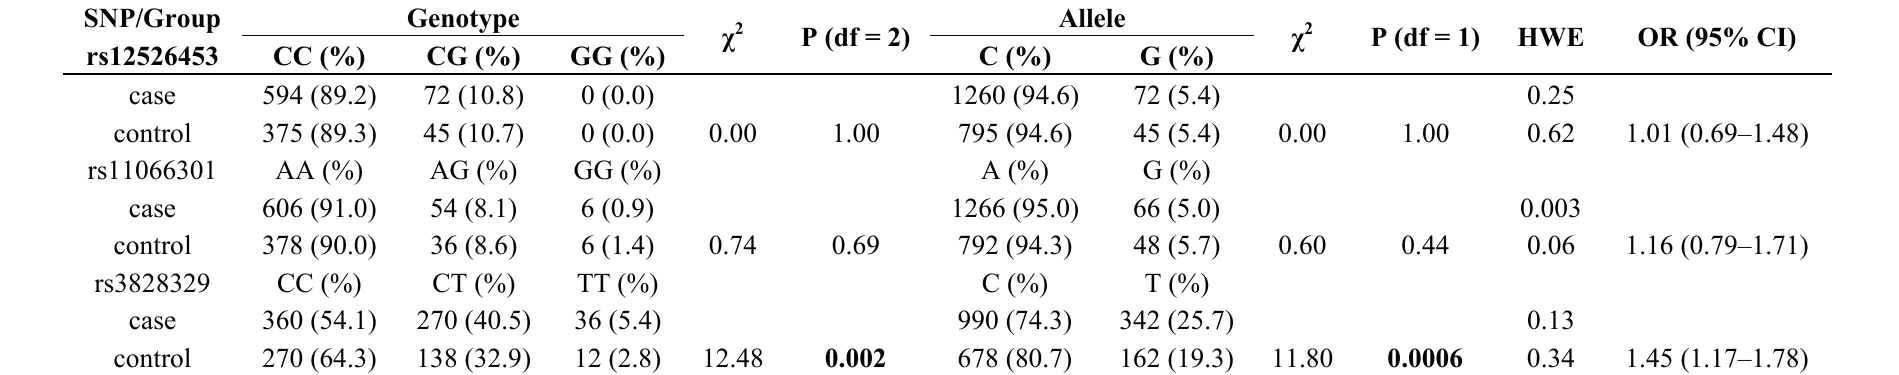
Table 1. Genotype and allele frequencies in SNPs in cases and controls.